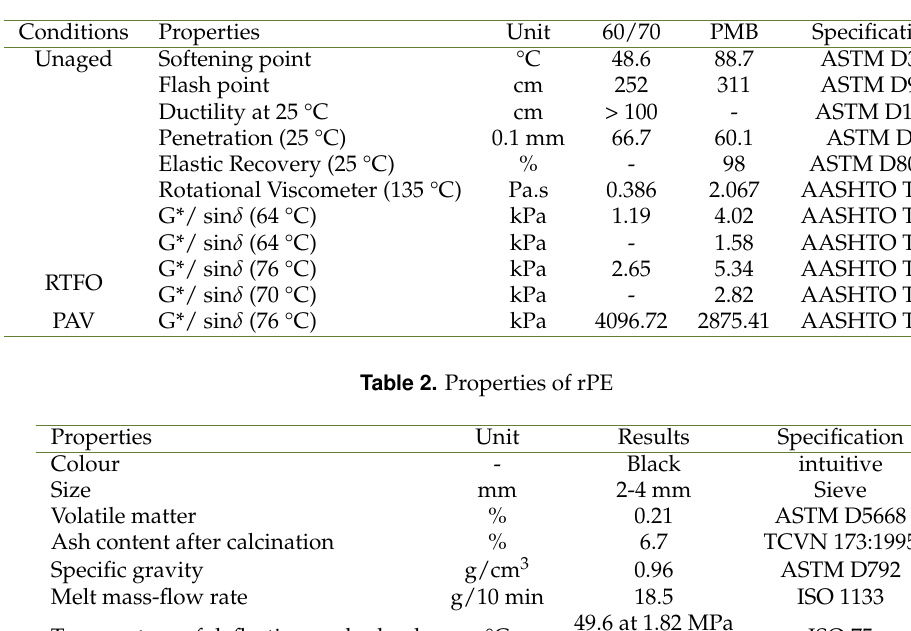
Table 1. Properties of asphalt 60/70 and PMB